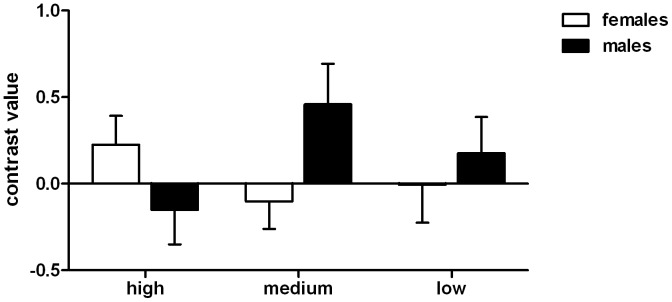
Contrast values for the three different androstadienone concentrations.Contrast values were extracted from the hypothalamus (region of interest at MNI coordinates x = 2; y = −6; z = 0, sphere diameter of 8 mm). Contrast values were determined for each of the three androstadienone concentration conditions and depicted separately for men and women. Error bars reflect the 95% confidence interval.